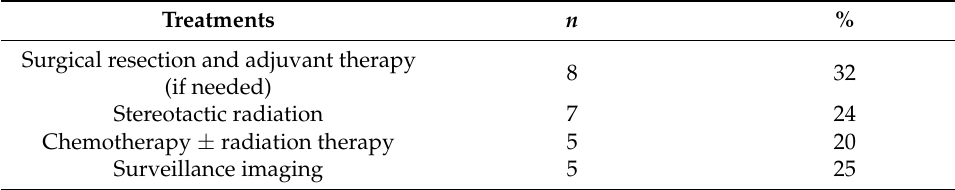
Table 3. Treatments based on biopsy